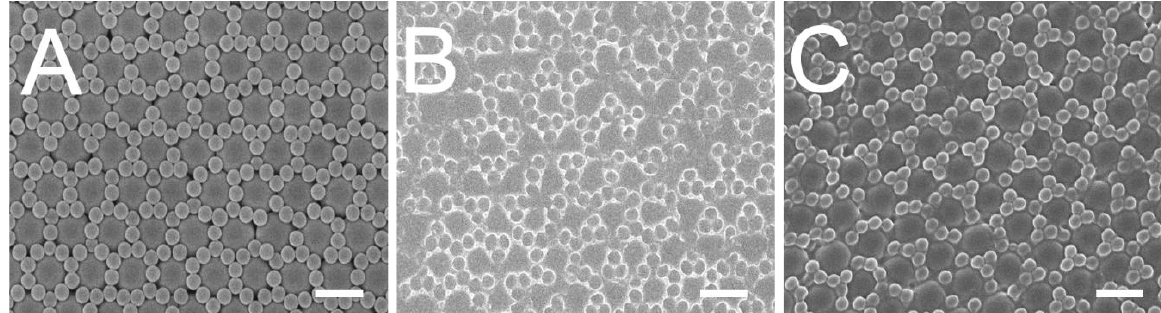
Figure 3. SEM images of ( A ) assembled 300 nm/900 nm binary array, ( B ) replicated soft mold, ( C ) imprinted nanofeatured film. (Scale bar: 1 μm).